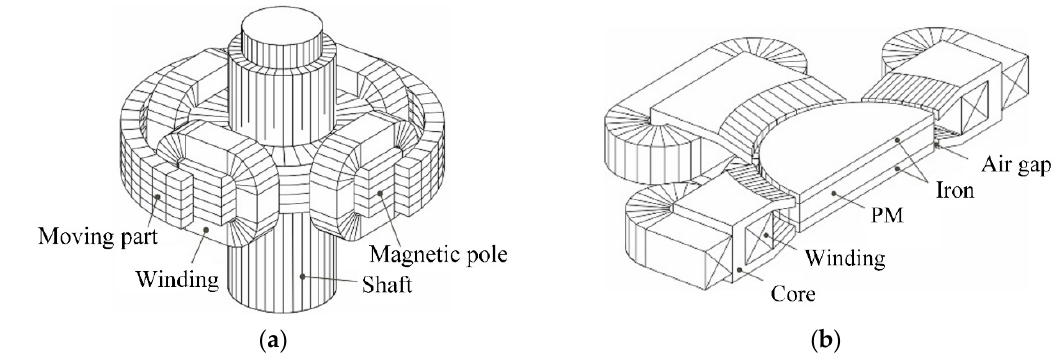
Figure 2. ( a ) Conventional magnetic bearing; ( b ) Hybrid magnetic bearing.